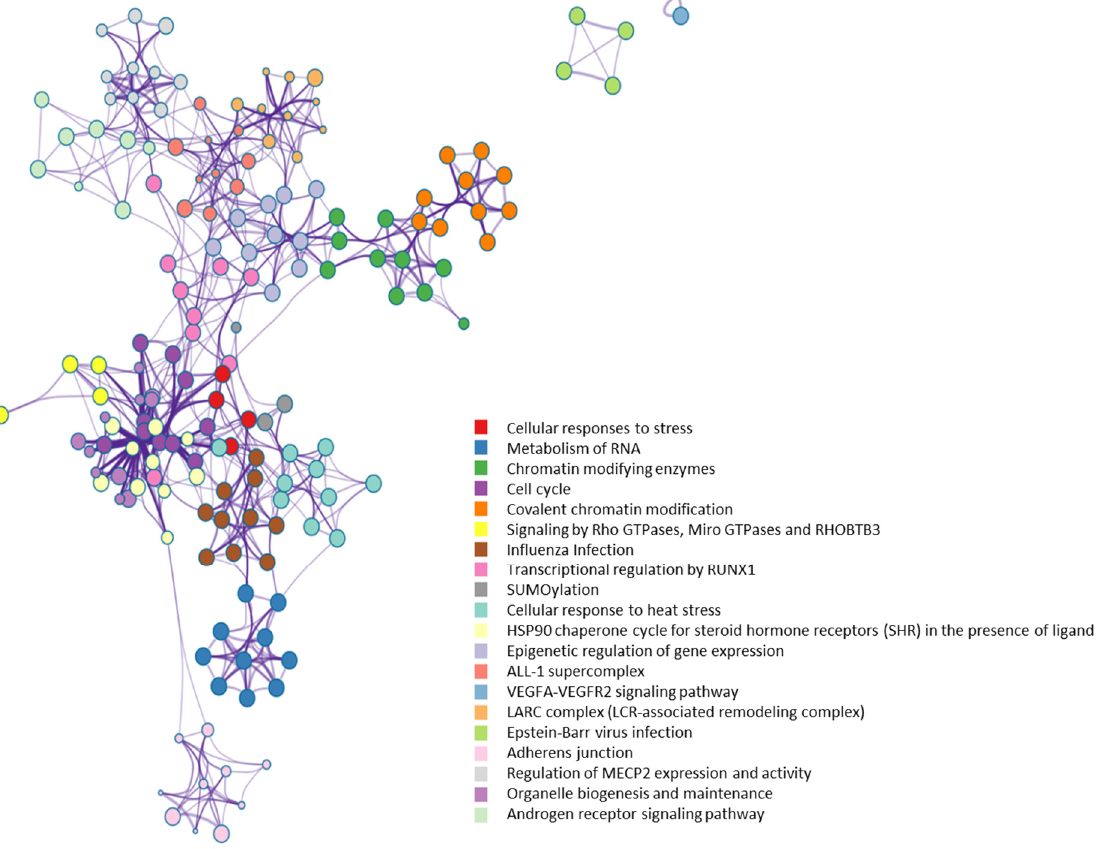
Figure 7. Highly clustered modules of OGT-interacting network. Each term is represented by a circle node, where its size is proportional to the number of input genes that fall into that term, and its color represents its cluster identity (i.e., nodes of the same color belong to the same cluster).